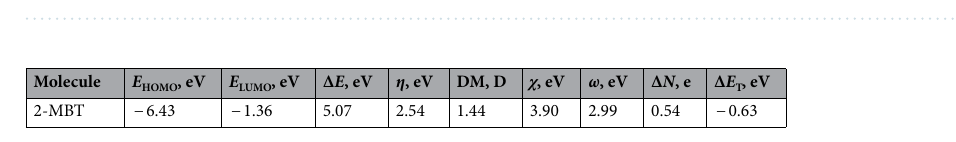
Figure 14. Adsorption of 2-MBT on Al and Al–Ti alloys surfaces.